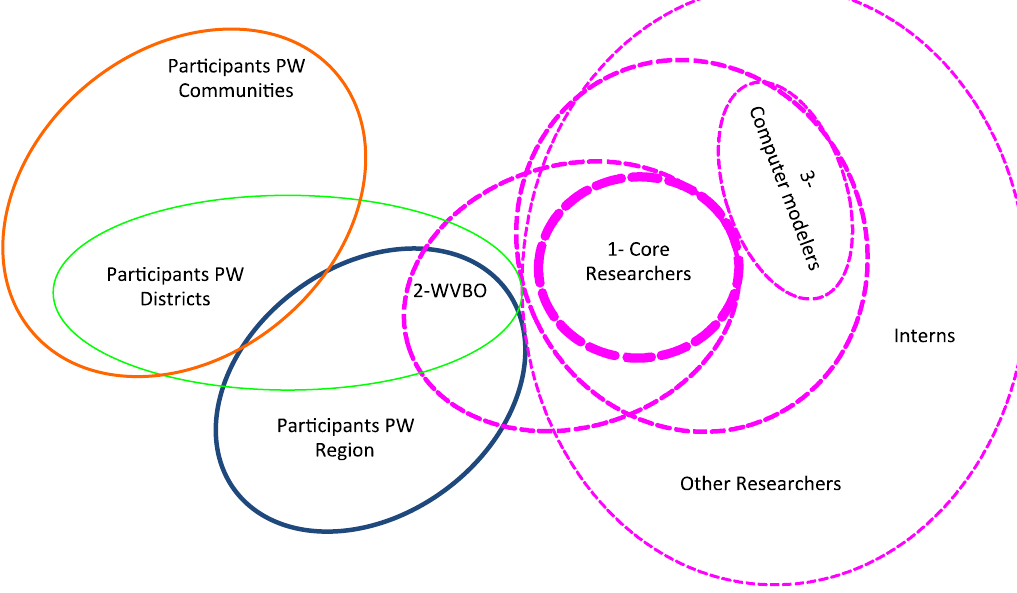
Figure 7. Interaction among and between project team members and problemshed actors according to the main roles they assumed in project activities. (Ellipses represent different “arenas of dialogue” in relation to project implementation. The dotted lines represent arenas and interactions that would not have existed without the project; plain lines represent interactions that exist regardless of the project activities [notably among watershed actors located on the left side of figure]. The thicker the line, the more intensive exchanges have been as part of the project. Purple indicates project team members; blue is used for regional representatives, green is used for district-level participants and orange is used for community-level participants) .